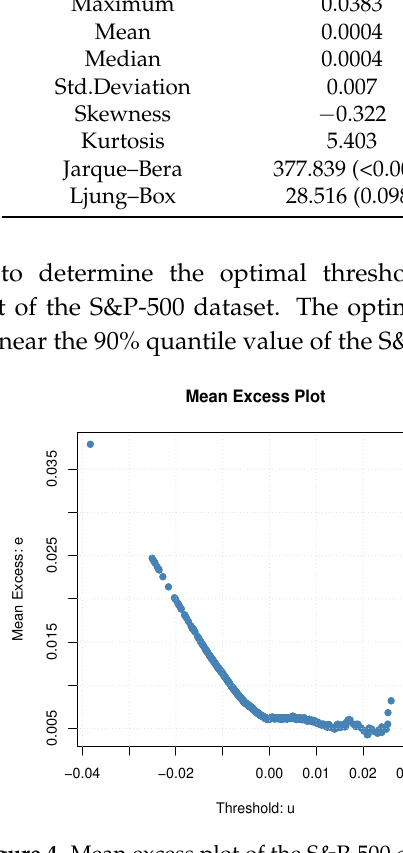
Figure 4. Mean excess plot of the S&P-500